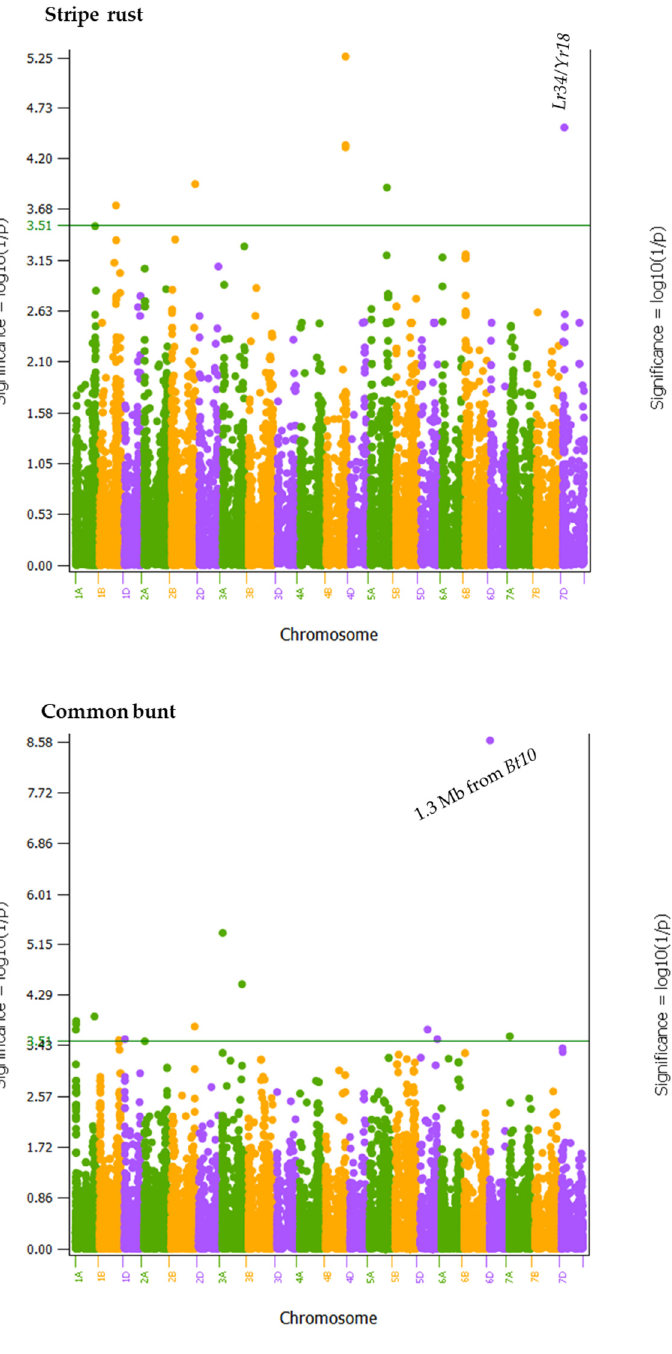
Figure 5. Manhattan plots of Log 10 (1/p) values computed using weighted mixed linear model, PC1 to PC3 from principal component analysis to account for population structure, best linear unbiased estimators (BLUEs) of disease scores computed from all environments, and genotype data of 23,342 polymorphic SNPs. The horizontal line shows the threshold p -value of 3.1 × 10 − 4 (3.51). The A, B, and D genomes are in green, orange, and purple colors, respectively. Chromosomes and physical positions are shown on the x -axis. See Table S6 for detailed results.